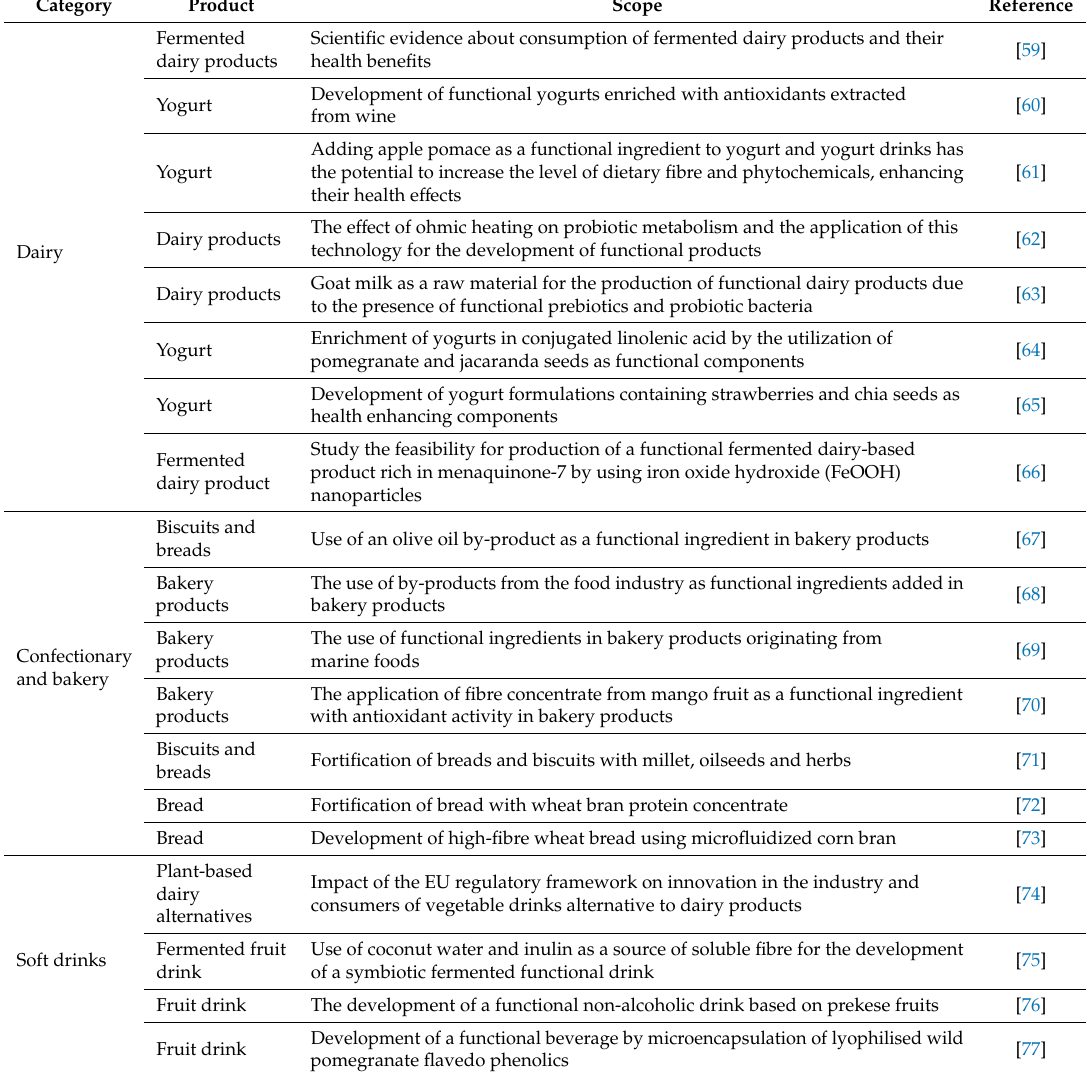
Table 2. Some relevant literature focusing on innovations in the domain of functional